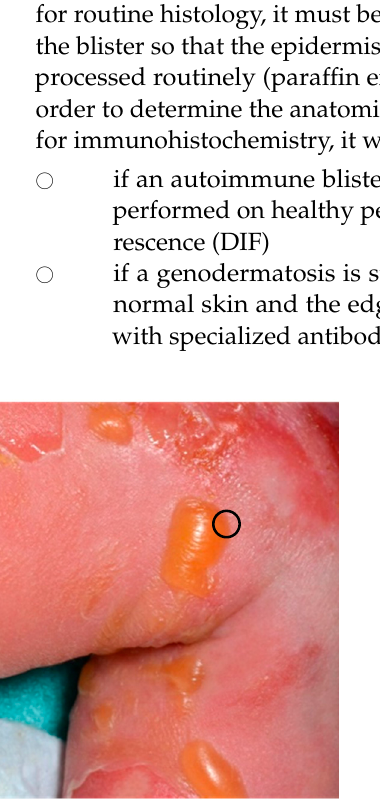
Figure 1. Skin biopsy for EBH, between normal skin and the edge of the blister.